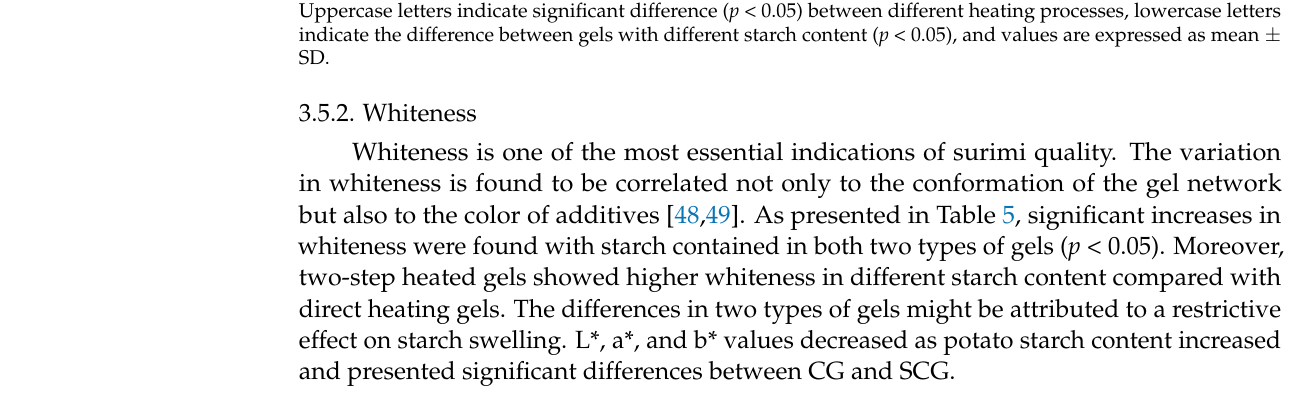
Table 5. Whiteness of starch–surimi mixtures subjected with different heating